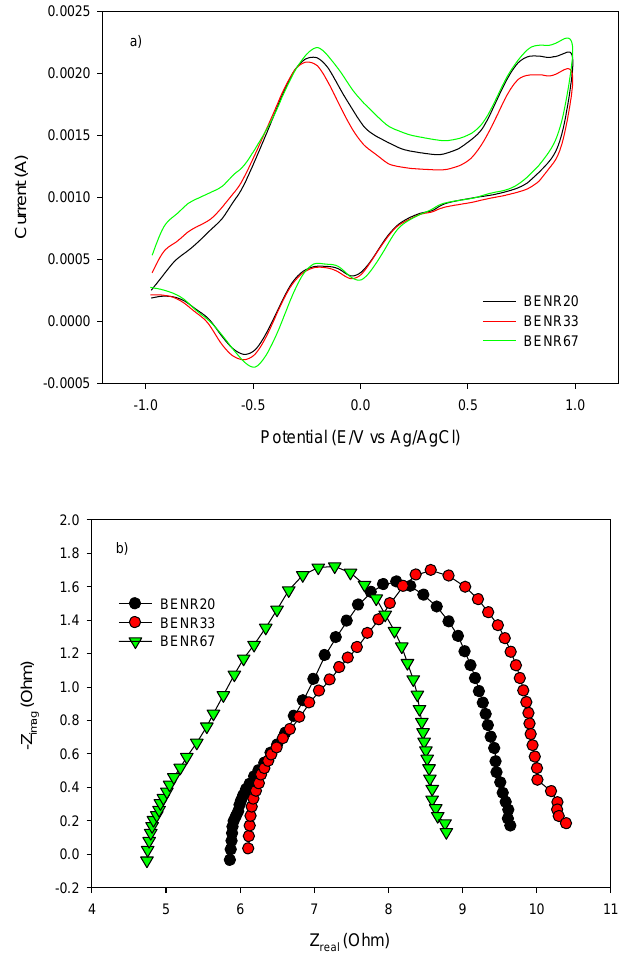
Figure 5. Electrochemical characteristics of the bulk solution depending on the electrostatic field: ( a ) Cyclic voltammogram and ( b ) Nyquist plot of the electrochemical impedance spectrum (EIS). In BENR67, the oxidation peak was 0.80 mA at − 0.20 V vs. Ag / AgCl, and the reduction peaks were 0.51 mA at − 0.01 V vs. Ag / AgCl and 0.90 mA at − 0.49 V vs. Ag / AgCl (Table 2). In BENR20 and BENR33, the redox peak potentials shifted slightly in the negative direction, compared to BENR67. However, the redox peak heights tended to decrease as the strength of the electrostatic field decreased. The redox peak height is in good agreement with the removals of ammonium and nitrite, which depend on the strength of the electrostatic field (Figure 2). For bioelectrochemical reactors, the substances contributing to the redox peak in the voltammogram can be abiotic redox compounds and